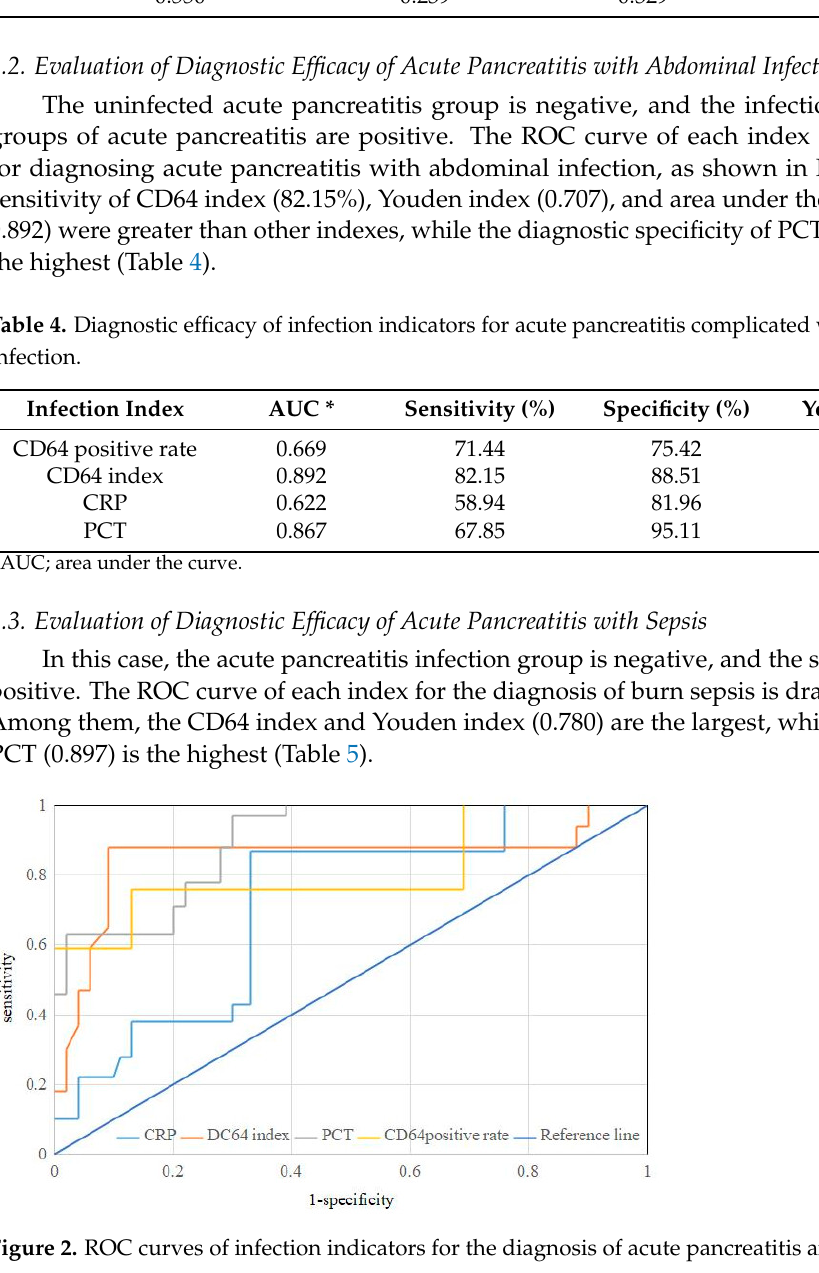
Table 4. Diagnostic efficacy of infection indicators for acute pancreatitis complicated with ab-